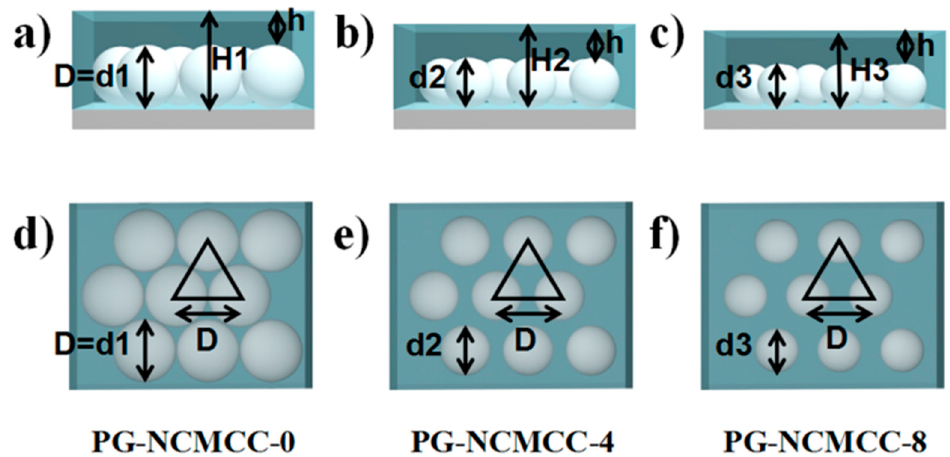
Figure 4. ( a – e ) pH dependence of the reflectance spectra of the UPPGF-x (x = ( a ) 0 min; ( b ) 2 min; ( c ) 4 min; ( d ) 6 min; ( e ) 8 min) sensors after equilibration in pH buffer solution; and ( f ) the corresponding shifts of the reflectance peak of